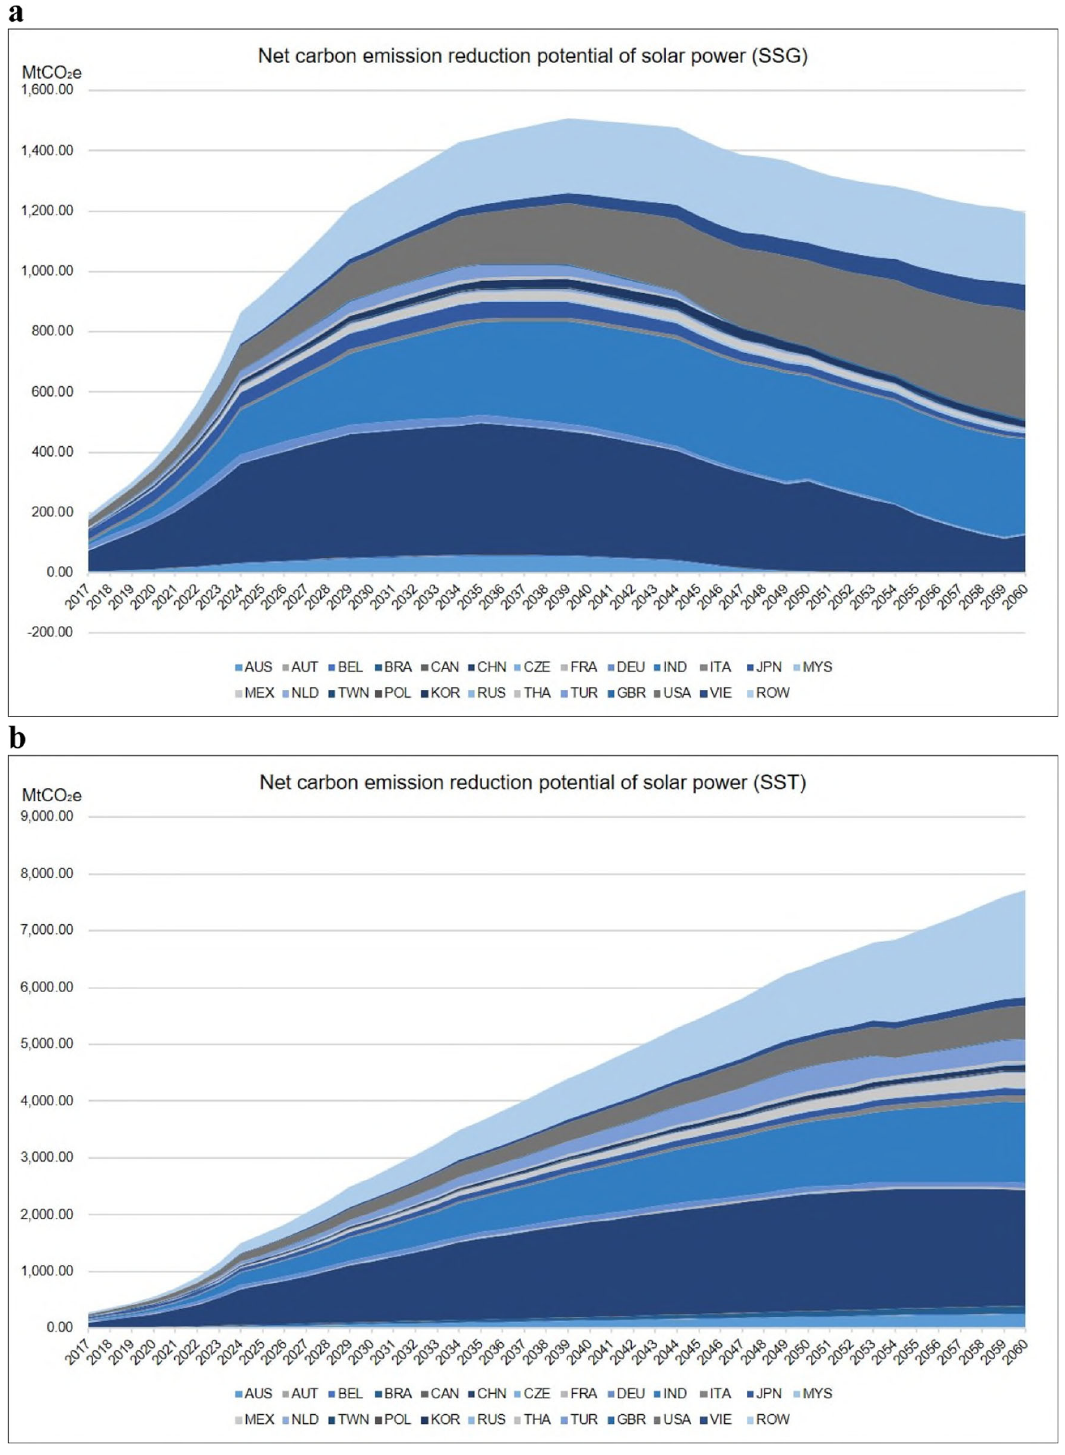
Fig. 5 Net carbon emissions reduction potential of solar photovoltaic (PV) power from 2017 to 2060. These fi gures re fl ect the net carbon emissions reduction potential of global PV application during 2017 – 2060. The ribbons in different blue and grey colour intensity scales indicate net carbon emissions reduction potential in different countries/economies. ROW is the abbreviation for the rest of the world. When counting net emission reductions, carbon emissions embodied in solar cells and modules and those embodied in the balance of system (BOS) and storage system are spread evenly over a 30-year lifetime and are then subtracted from the gross carbon reduction potential of PV power replacement. a Re fl ects the net carbon emissions reduction potential when solar PV power is applied to replace non-PV electricity (SSG). The carbon emissions reduction potential in some countries/economies fi rst increases and then decreases. It is reasonable that renewable energy will gradually occupy a larger share in the local grid power mix, and incremental solar PV power substitution will result in smaller carbon abatement. b Re fl ects net carbon emissions reduction potential when solar PV power is applied to replace fossil fuel electricity